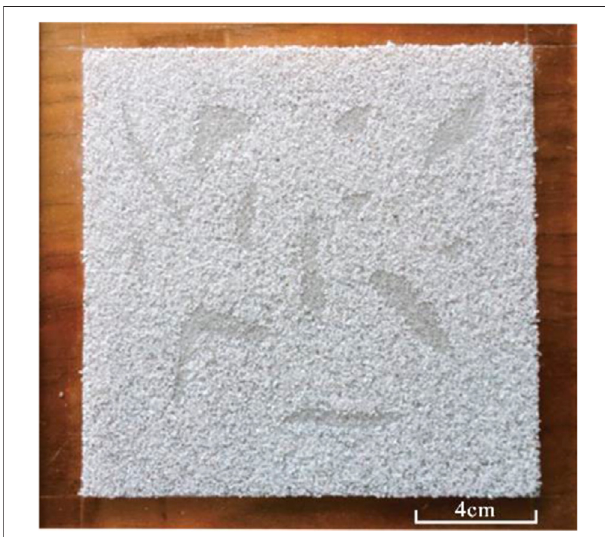
FIGURE4| Heterogeneousformationofthevisualizationglassplatemodel.